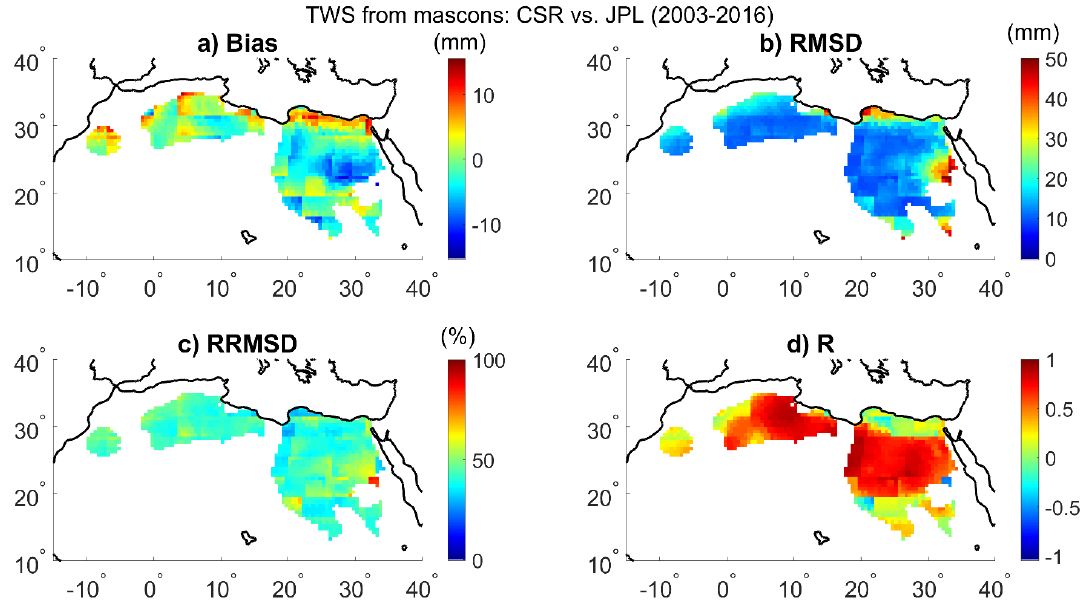
Figure A2. Maps of bias ( a ); RMSD ( b ) RRMSD ( c ); R ( d ) between TWS from CSR and JPL mascon solutions over 2003–2016.